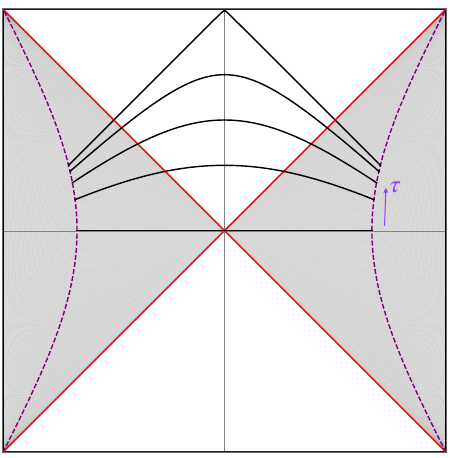
Figure 9 . Extremal surfaces with anchoring on the stretched horizon r = ρL in dS d +1 . Each black curve denotes an extremal surface associated with a conserved momentum P u ( τ ) ≥ 0 and a boundary time τ ≥ 0